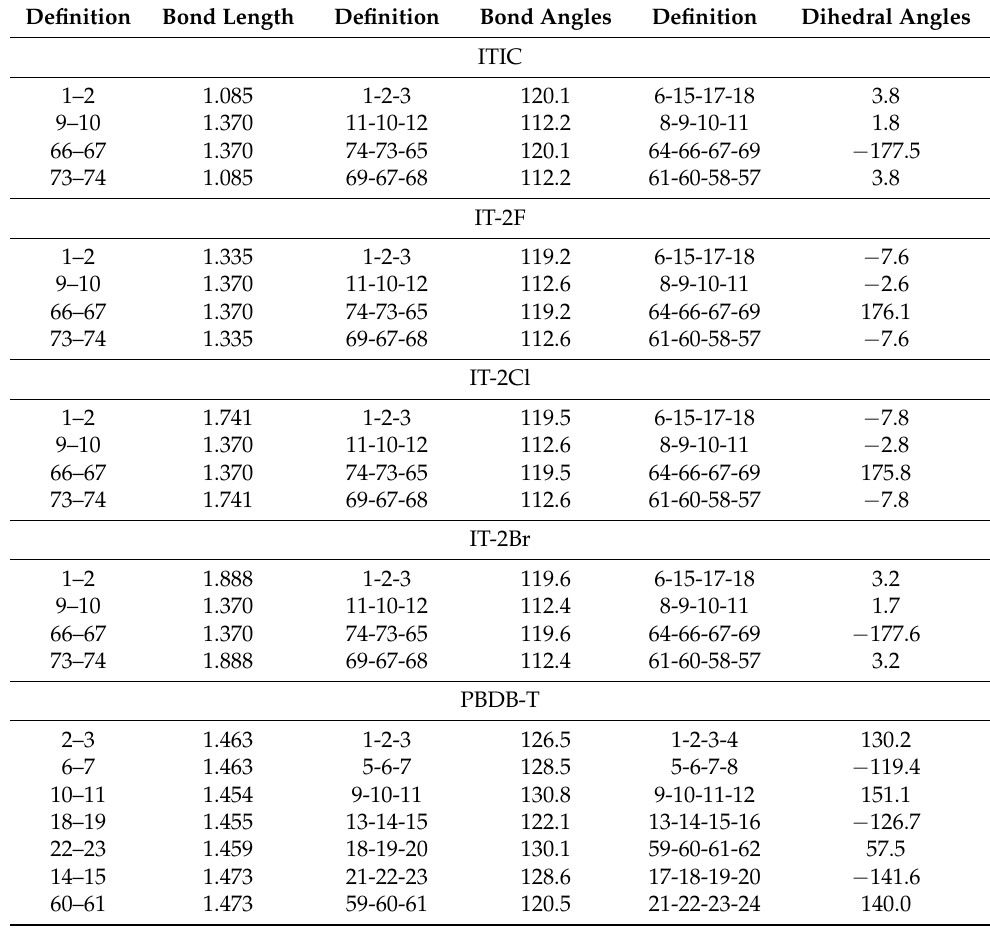
Table 1. The selected geometrical parameters, including bond length (in Å), bond angles (in ◦ ) and dihedral angles (in ◦ ) which were defined by two, three, and four atoms. ( ω B97XD/6-31G**). Definition Bond Length Definition Bond